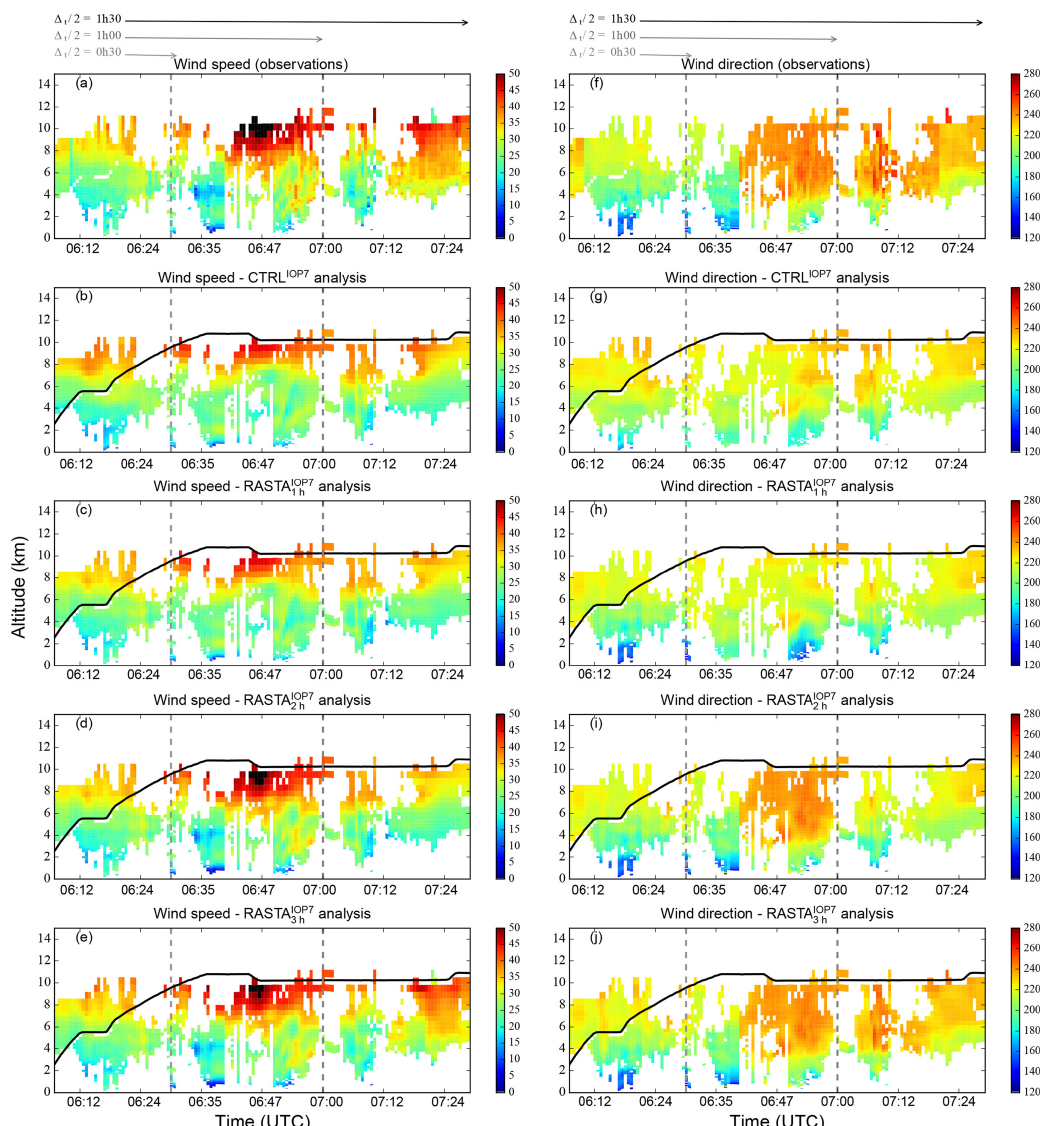
Figure 5. Wind speed (a–e) and wind direction (f–j) for (a, f) the observations, (b, g) the CTRL IOP7 , (c, h) the RASTA IOP7 RASTA IOP7 and (e, j) the RASTA IOP7 06:00UTC analyses on 26 September 2012 (IOP7a). The three different assimilation windows (cid:49) t 2h 3h are delimited by the vertical lines. The aircraft’s altitude above sea level is represented by the black